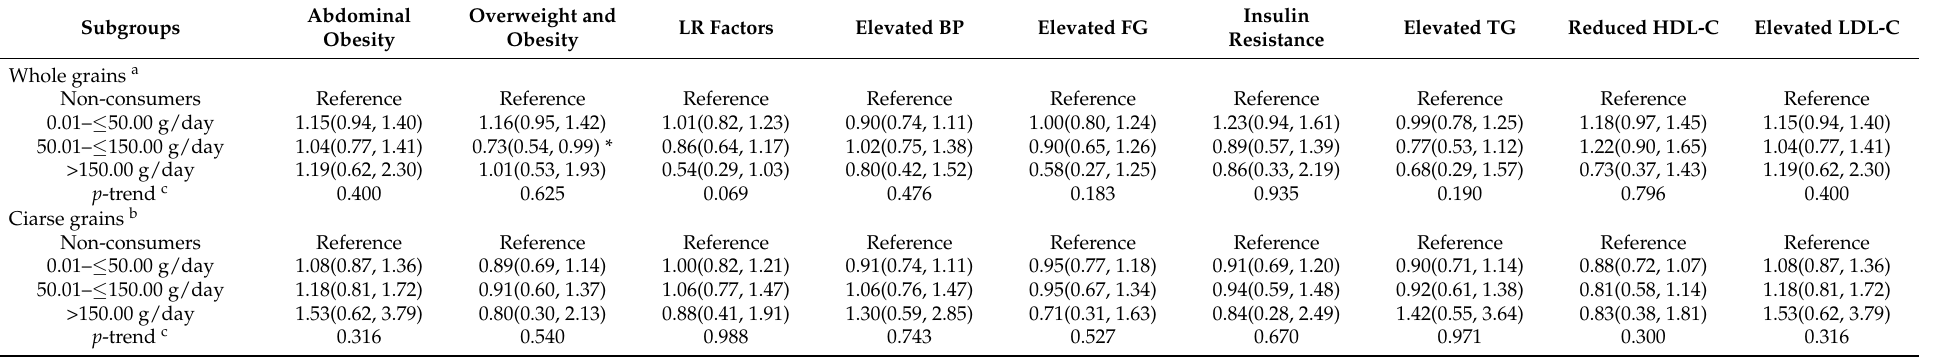
Table 4. OR (95% CI) of CMFs in relation to intakes of whole grains and coarse grains in Chinese adults,